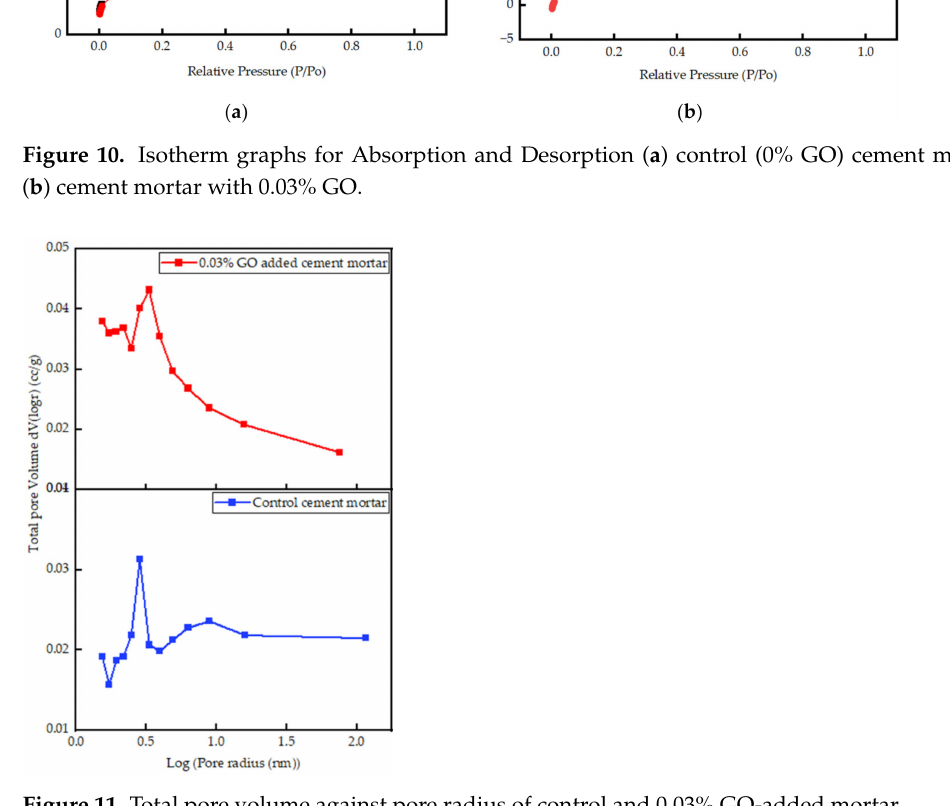
Figure 11. Total pore volume against pore radius of control and 0.03% GO-added